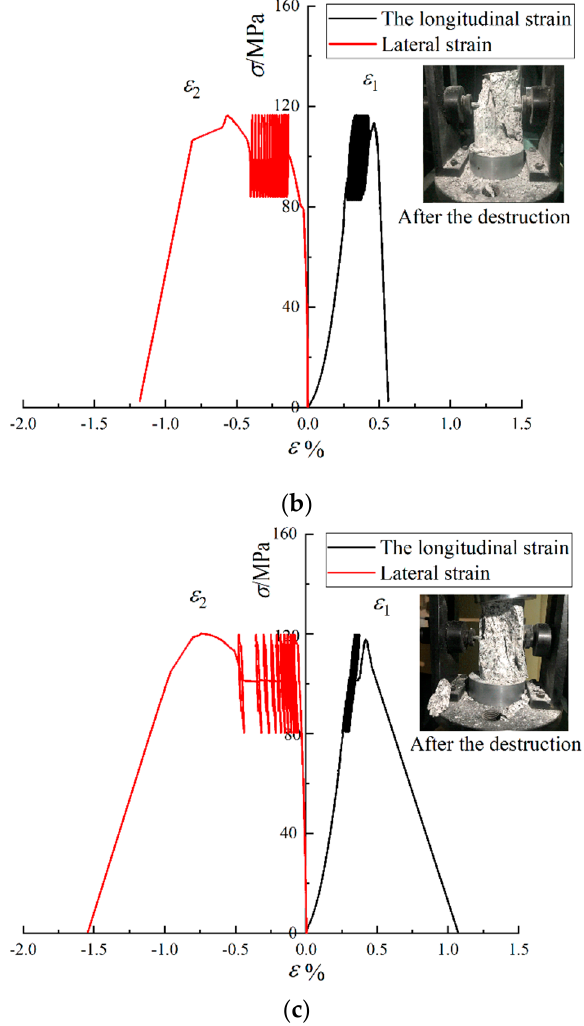
Figure 6. Stress–strain curves under 70% of the UCS: ( a ) Gra70% − 1; ( b ) Gra70% − 2; ( c ) Gra70% − 3.